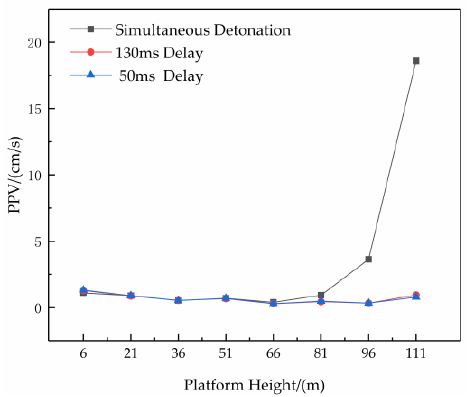
Figure 8. Line graph of the peak particle velocity of the 6 – 111 platform.